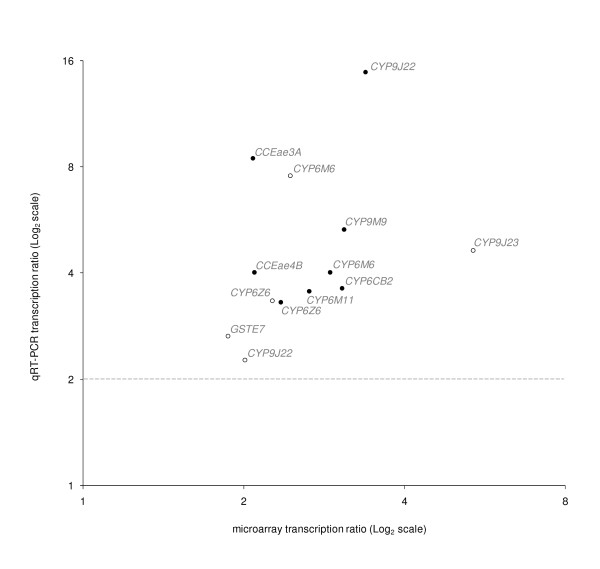
Real-time quantitative RT-PCR validation of microarray data. Validation of differential transcription between the two strains was performed on 11 selected genes in 4th-stage larvae (white dots) and 3-days old adults (black dots). Transcription ratios obtained from real-time quantitative RT-PCR experiments were normalized with the two housekeeping genes AeRPL8 and AeRPS7 and shown as mean value over 3 independent biological replicates.